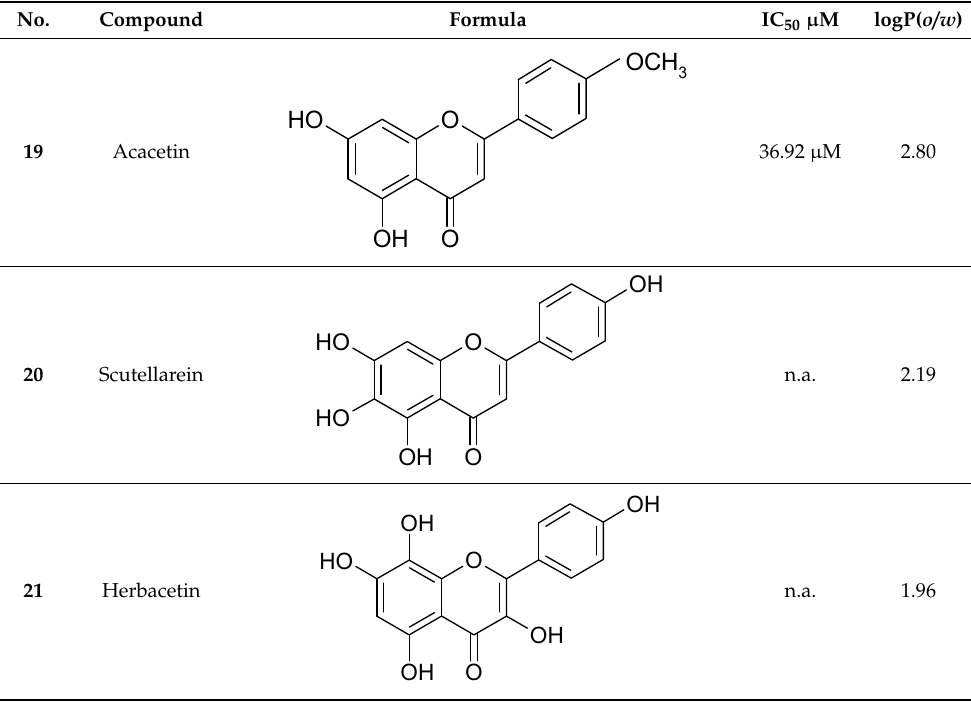
Table 2. Compounds tested in the CCID assay (MCF-7 spheroids on LECs) as a proof of concept, the respective IC 50 ( μ M) and calculated logP (o/w) values.